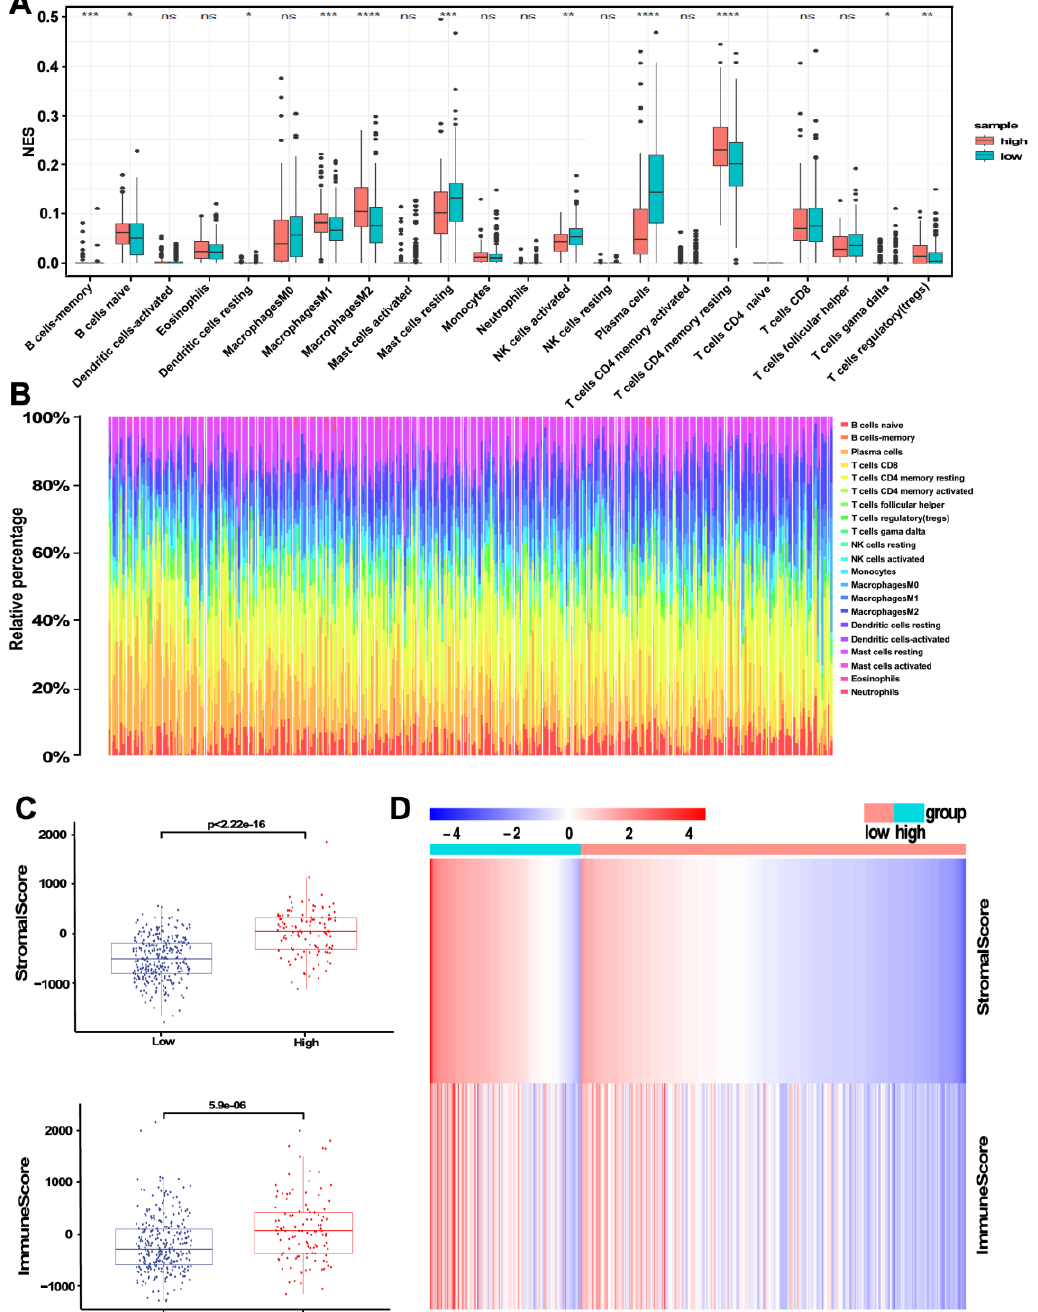
Figure 7. Immune infiltrating cell profile in PCa and correlation analysis. ( A ) The subgroup analysis of 22 immune infiltrating cells between the high-GS and low-GS groups. Red represents high-GS group while green represents low-GS group. (* p < 0.05; ** p < 0.01; *** p < 0.001; **** p < 0.0001) ( B ) Bar plot of the proportion of immune infiltrating cells in the high- and low-risk PCa groups. ( C ) Box plots of immune score and stromal scores between the high- and low-risk groups. ( D ) Heat map of immune score and stromal scores between the high- and low-risk groups.